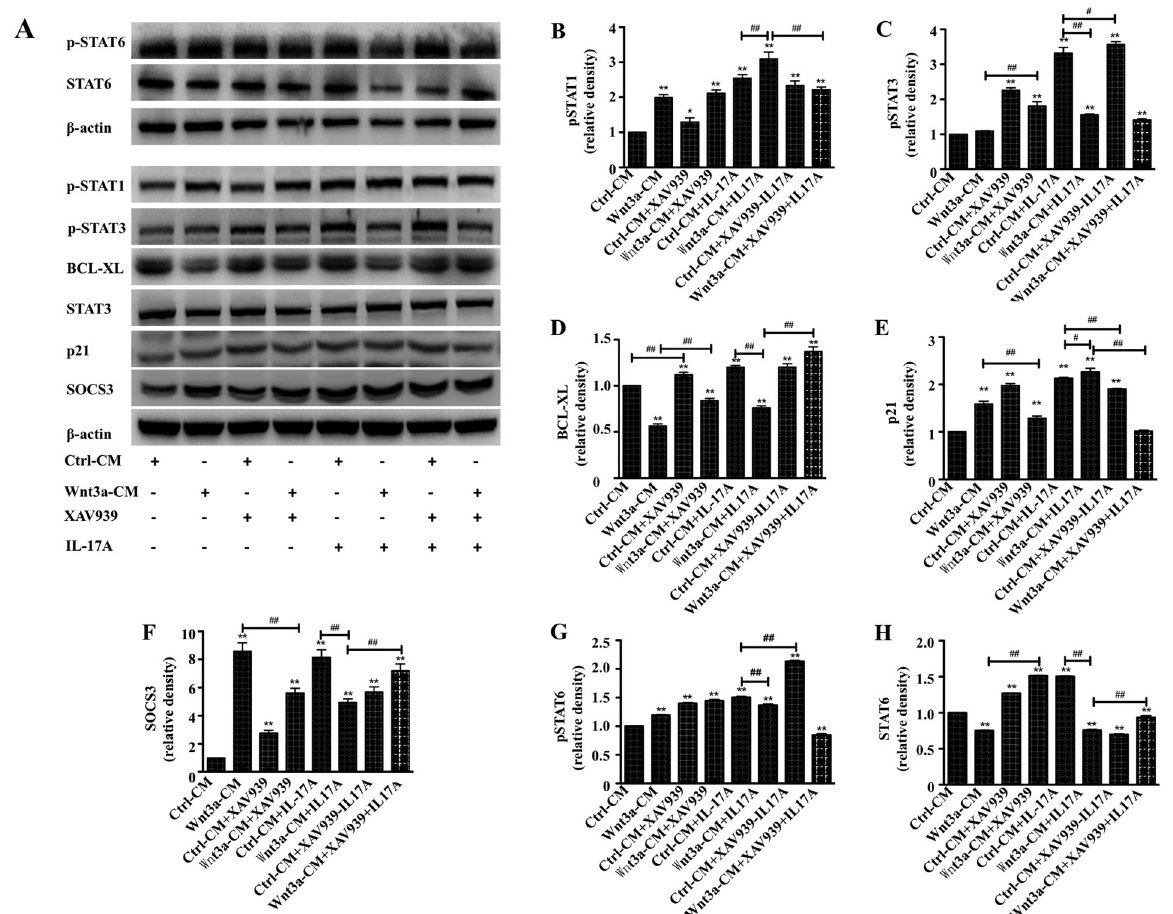
Figure 6. Stat signaling is involved in Wnt3A and IL-17A-mediated macrophage polarization in RAW264.7 cells. A , Representative images of immunoblots of indicated proteins of Stat signaling cascade in cells treated with different conditions. Semi-quantitative analysis of the expression of proteins in ( A ) showing fold changes of protein abundance of p-STAT1 ( B ), p-STAT3 ( C ), BCL-XL ( D ), p21 ( E ), SOCS3 ( F ), p-STAT6 ( G ), and STAT6 ( H ) in cells treated with Wnt3a-CM and/or XAV939 in the presence or absence of rhIL-17A determined by densitometry assay using ImageJ software Fiji. Data are reported as means ± SD from three independent experiments. *P o 0.05, **P o 0.01 compared to the Ctrl-CM group, # P o 0.05, ## P o 0.01 compared to the indicated groups